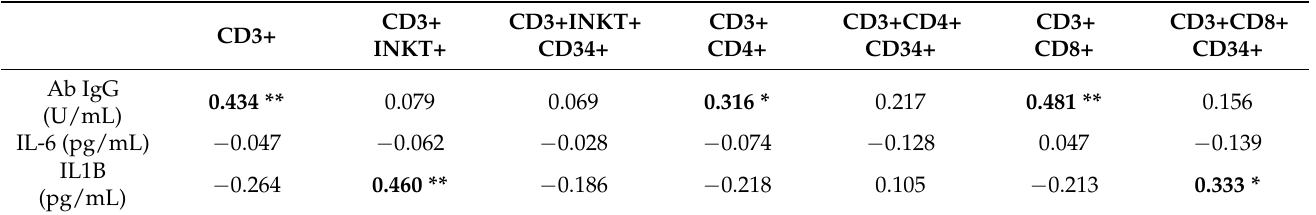
Table 12. Correlations between umbilical cord blood lymphocyte subsets and umbilical cord blood cytokines concentrations. Pearson’s significant correlation coefficients have been